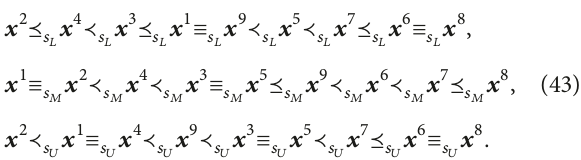
the other four lines in the first column show the weights of attributes determined randomly, and the second column shows the final ranking of the nine schemes. The ranking is determined via the values of projections of the approach to MGDMP based on determining the weights of experts by using projection method; i.e., the smaller the projection the better the alternative in [5]. From Table 3, it is found that the ranking results rely on the weights of attributes determined by the experts, and different weights lead to different